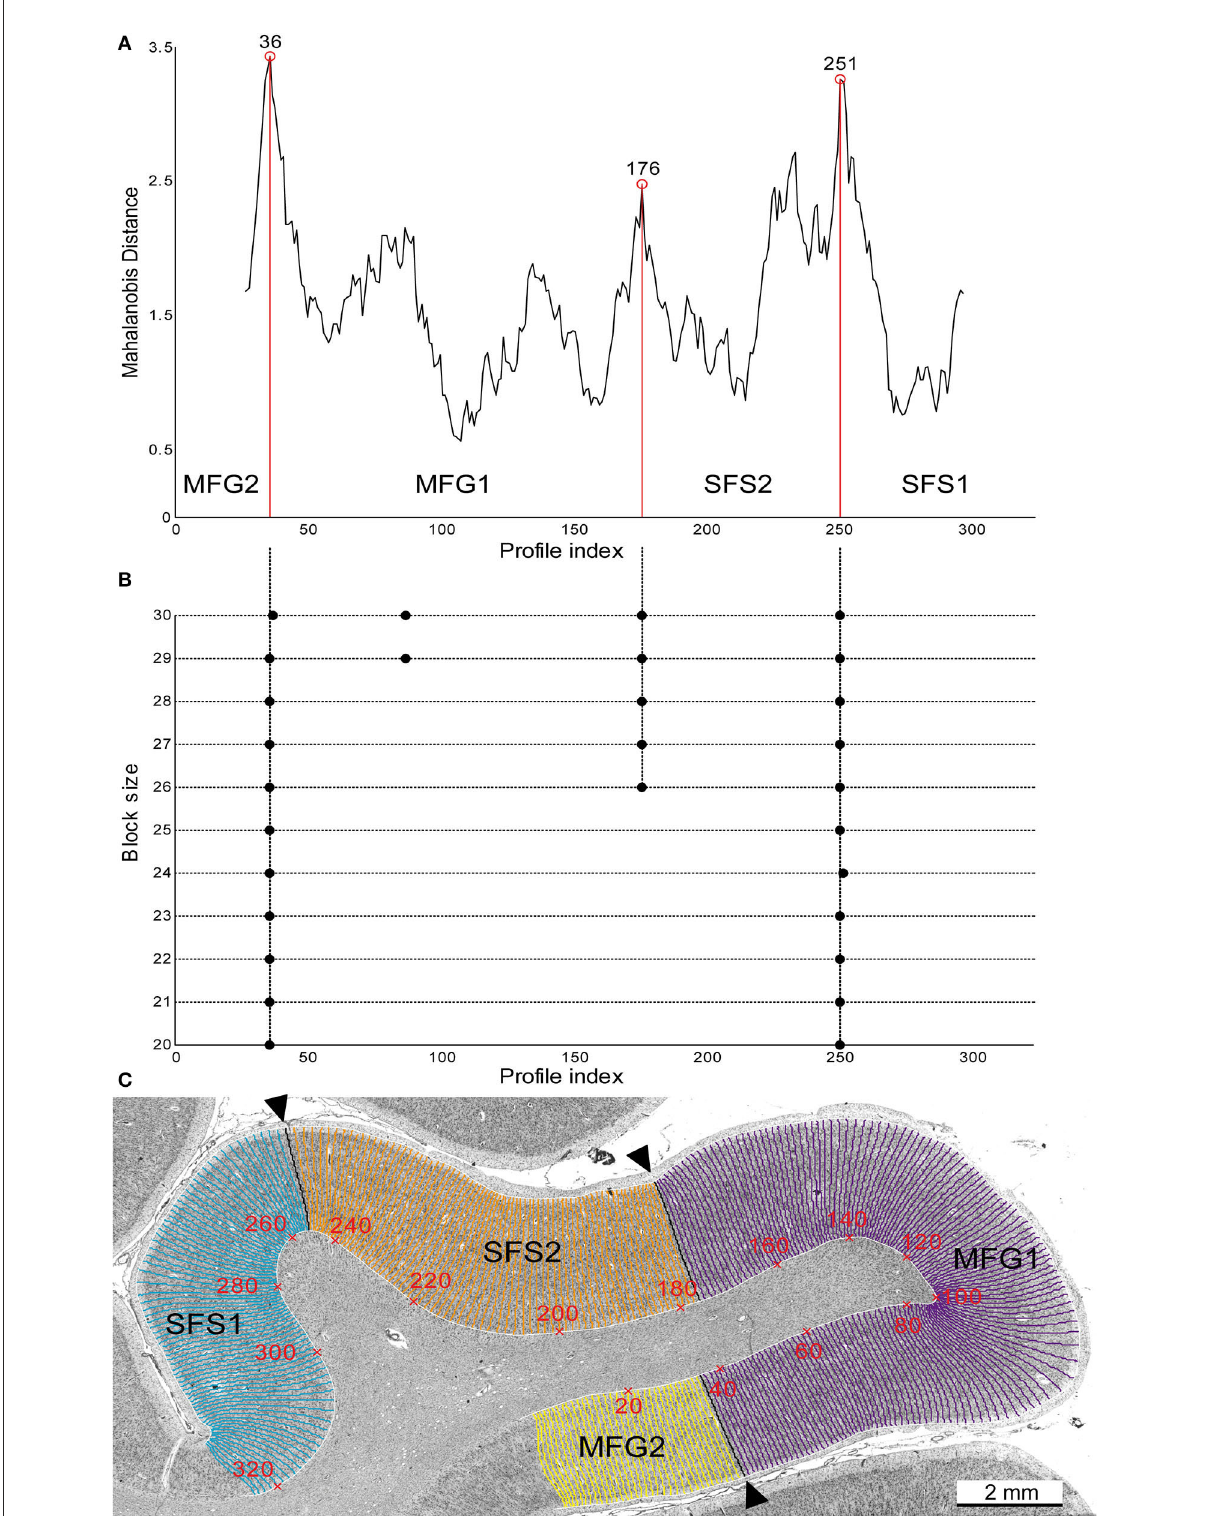
FIGURE2 Observer-independent border detection. Significant maxima of the Mahalanobis distance (MD) at profile numbers 36, 176, and 251 (labeled with red circles) are plotted against the profile index (A) . These positions indicate the borders between SFS2 and MFG1 and the neighboring areas SFS1 and MFG2 (A,C) . Significant maxima (indicated by black dots) were tested for different block sizes ( n = 20–30) and accepted as significant